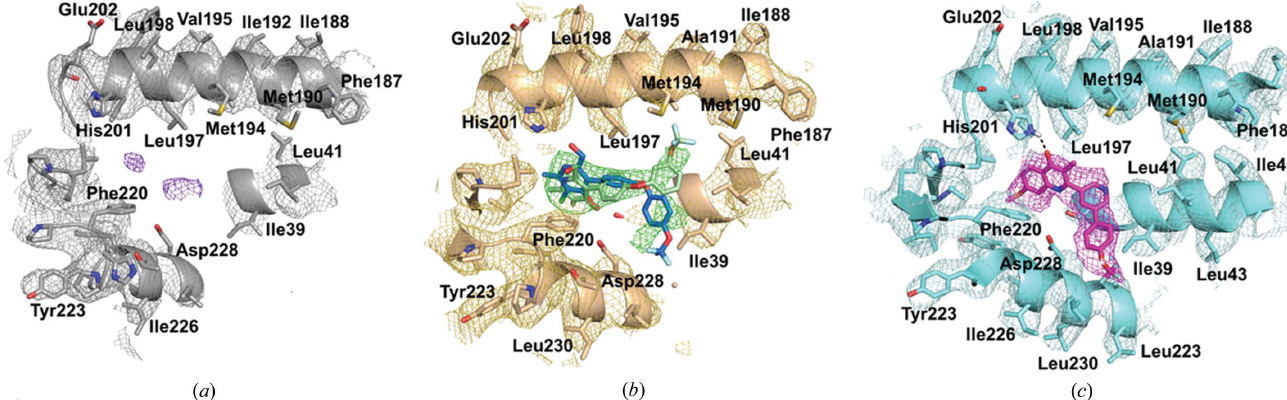
Figure 3 Analysis of the Q i site in the three different cryo-EM maps with the density contoured at 3 (cid:3) . ( a ) The Q i site in the apo bc 1 cryo-EM map shows minimal density (purple mesh) which does not correspond to any side chains or the haem b L group, suggesting noise within the map or that the natural substrate ubiquinone is bound in a small number of bc 1 molecules. ( b ) The Q i site in the cryo-EM map of bc 1 –GSK932121. The inhibitor density (green) suggests there are two modes of inhibitor binding, accompanied by rotation around the oxygen–carbon bond. The binding pose shown in green agrees with the crystal structure, with the trifluoromethyl group pointing towards Met194. There is additional density which suggests that the trifluoromethoxyphenyl group could be rotated and point towards Asp228, revealing an additional mode of binding (shown in blue). ( c ) The Q i site in the cryo-EM map of bc 1 – SCR0911, with the inhibitor shown in pink and located in strong density. The inhibitor is expected to make a hydrogen-bond contact with His201 and strongly fits the